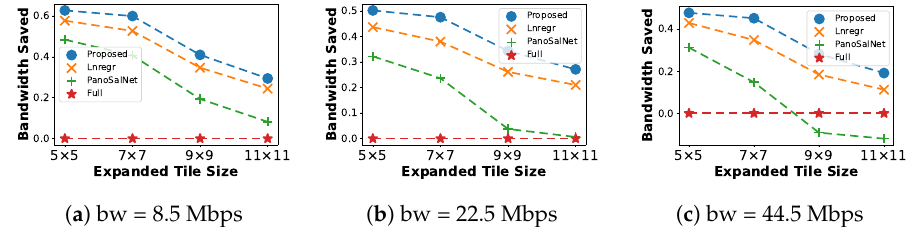
Figure 7. Percentage of Bandwidth Saved for different head prediction models under different bandwidth